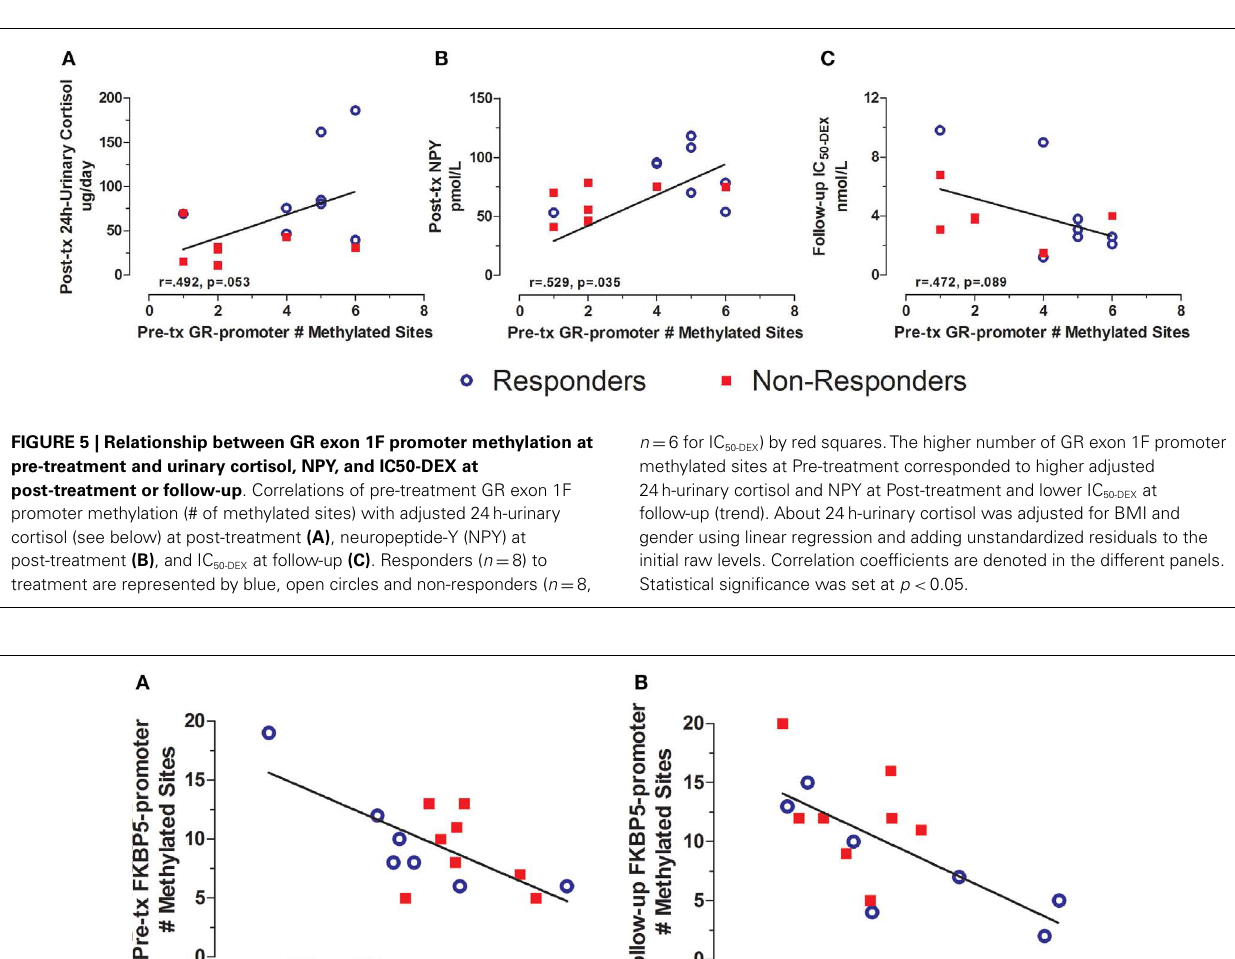
by red squares. Higher pre-treatment plasma cortisol and Follow-up post-DEX adjusted ACTH associated with lower FKBP5 promoter methylation at pre-treatment and Follow-up, respectively. Follow-up post-DST ACTH was adjusted for dexamethasone levels and pre-DST ACTH levels using linear regression and unstandardized residuals were added to the initial raw levels. Correlation coefficients are denoted in the different panels. Statistical significance was set at p <